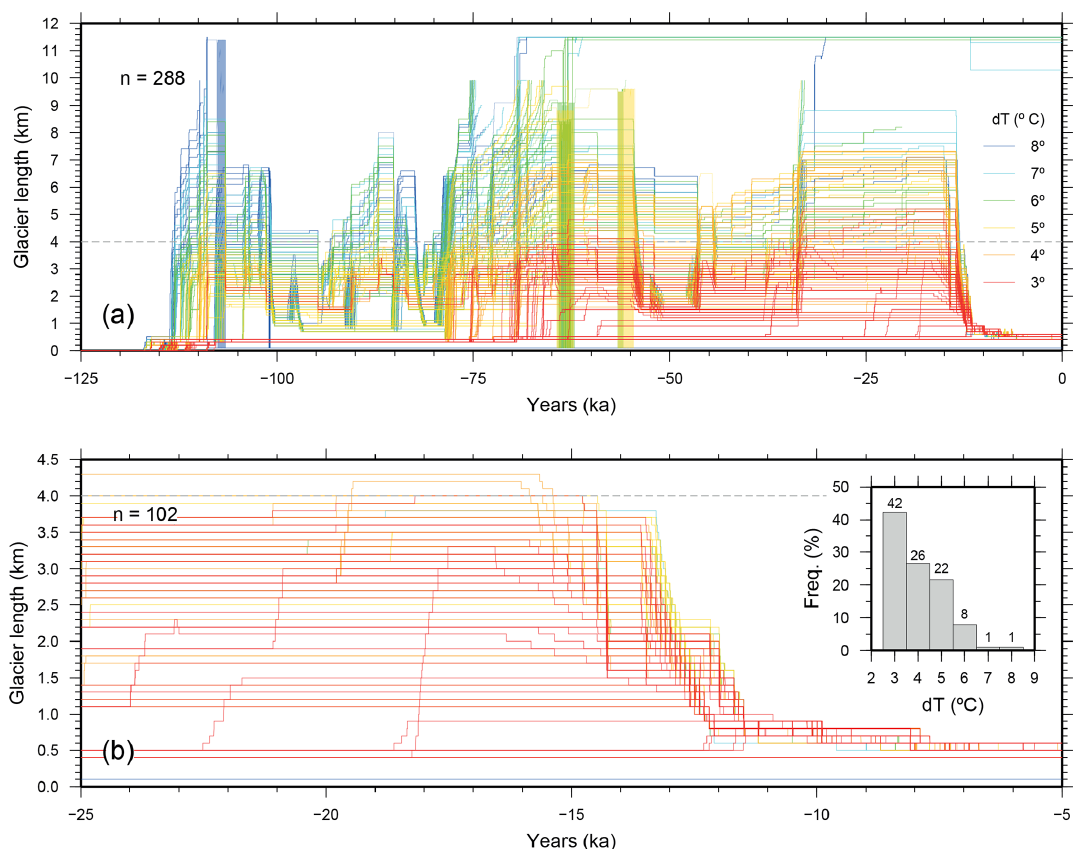
Figure 7. Ensemble of glacier simulations coloured according to the mean annual air temperature depression used to scale the EPICA Dome C or sea surface temperature time series forcing of (a) all 288 flow line model runs and (b) the 102 simulations that fit the radiocarbon constraint. Inset shows the frequency of MAAT depressions in this subset from 3 to 8 ◦